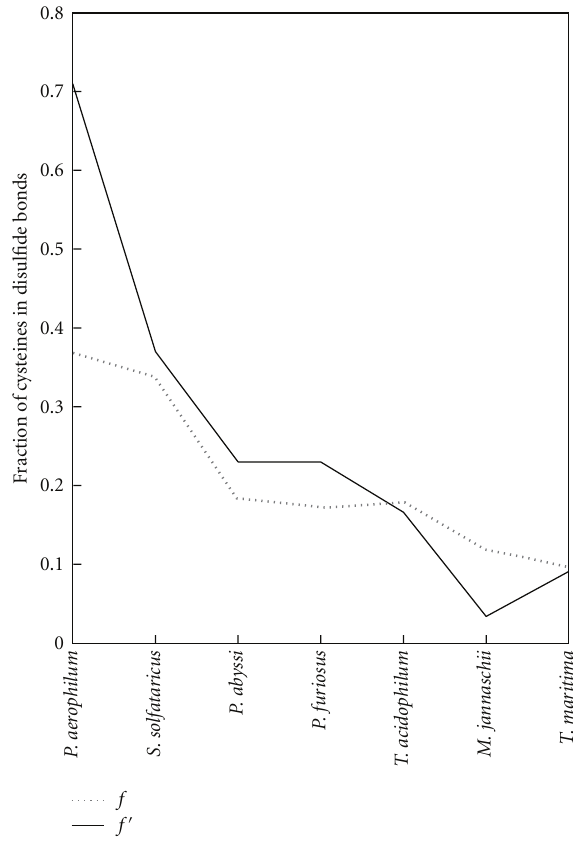
Figure 5: Correlation of the predicted disulfide abundance pa- rameter, f , with the corresponding value f (cid:3) determined from the protein structure databank for thermophiles with significant coverage. Selected thermophiles were analyzed if they had su ffi cient representation in the PDB to obtain a reasonable estimate of the disulfide abundance. Metalloproteins were excluded. See Section